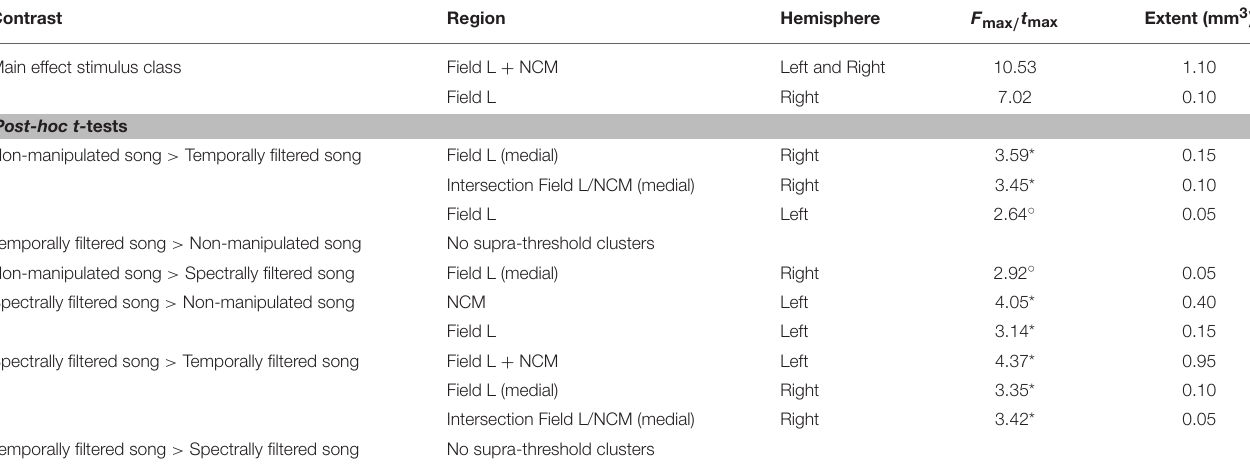
TABLE 1 | Summary of all supra-threshold clusters ( p uncorrected < 0.005) in the voxel-based analysis comparing BOLD responses to the different stimulus types.